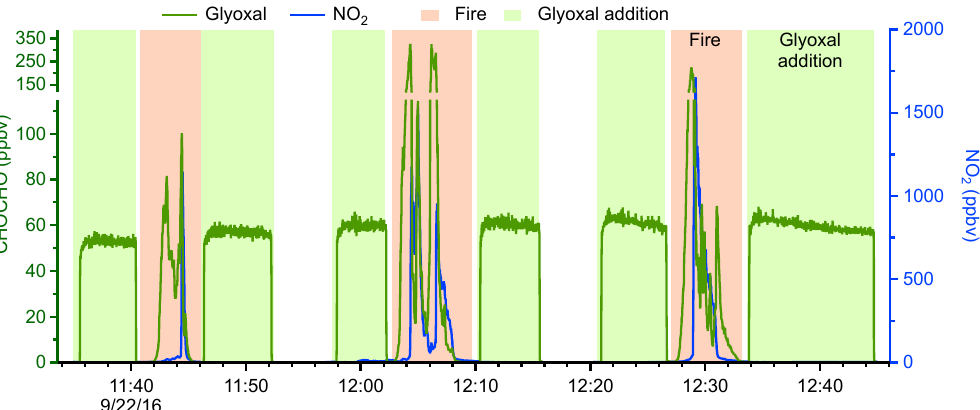
Figure 2. Data from a filter transmission experiment conducted in Boulder, Colorado, prior to the FIREX campaign. Shown are the retrieved glyoxal (green) and NO 2 (blue) concentrations from the three fire periods (orange shading) and the additions using the bubbler (green shading). The filter was not changed during the